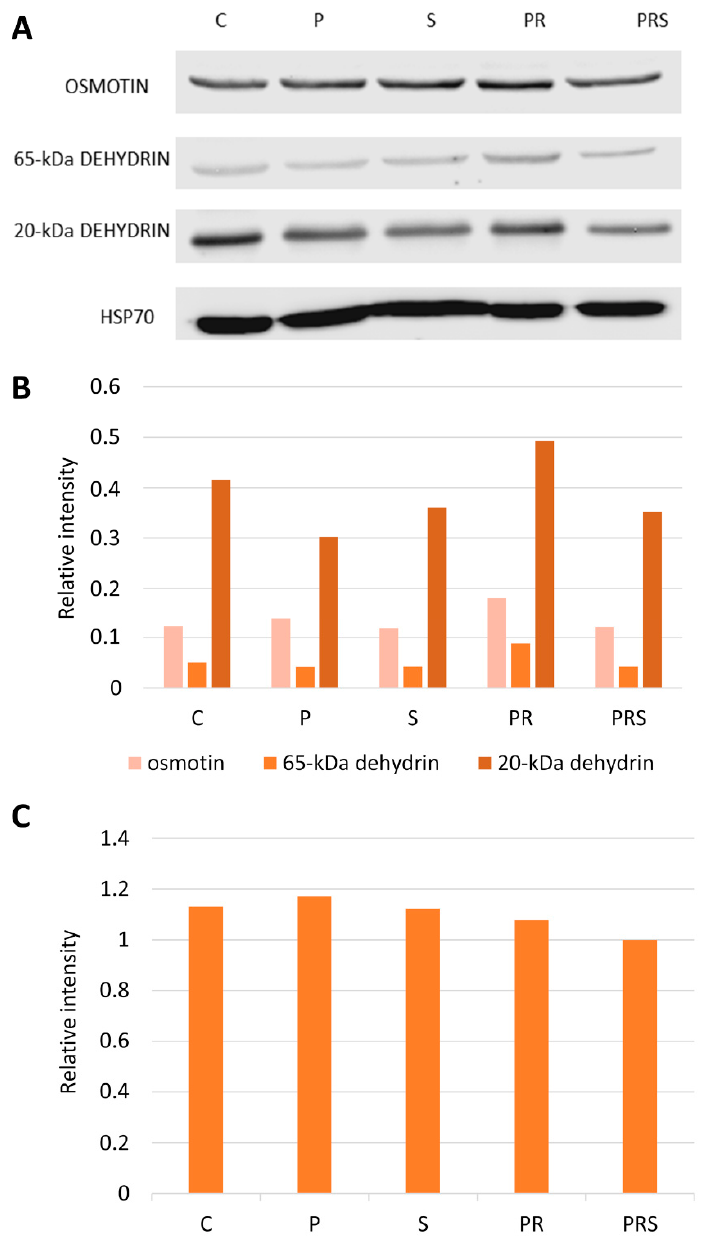
Figure 3. Immunoblotting with anti-osmotin, anti-dehydrin and anti-HSP70 antibody: ( A ) Detection of osmotin, dehydrin and HSP70 in the different pollen samples. Lane 1, control sample (C); Lane 2, primed sample (P); Lane 3, stressed sample (S); Lane 4, primed and recovered sample (PR); Lane 5, primed, recovered and stressed sample (PRS). A total of 30 μ g of proteins was loaded in each lane; ( B ) measurement of osmotin, 65-kDa dehydrin and 20-kDa dehydrin immunoblot intensity; ( C ) Measurement of HSP70 blot intensity. In all cases, data were normalized against actin, chosen as the reference protein.